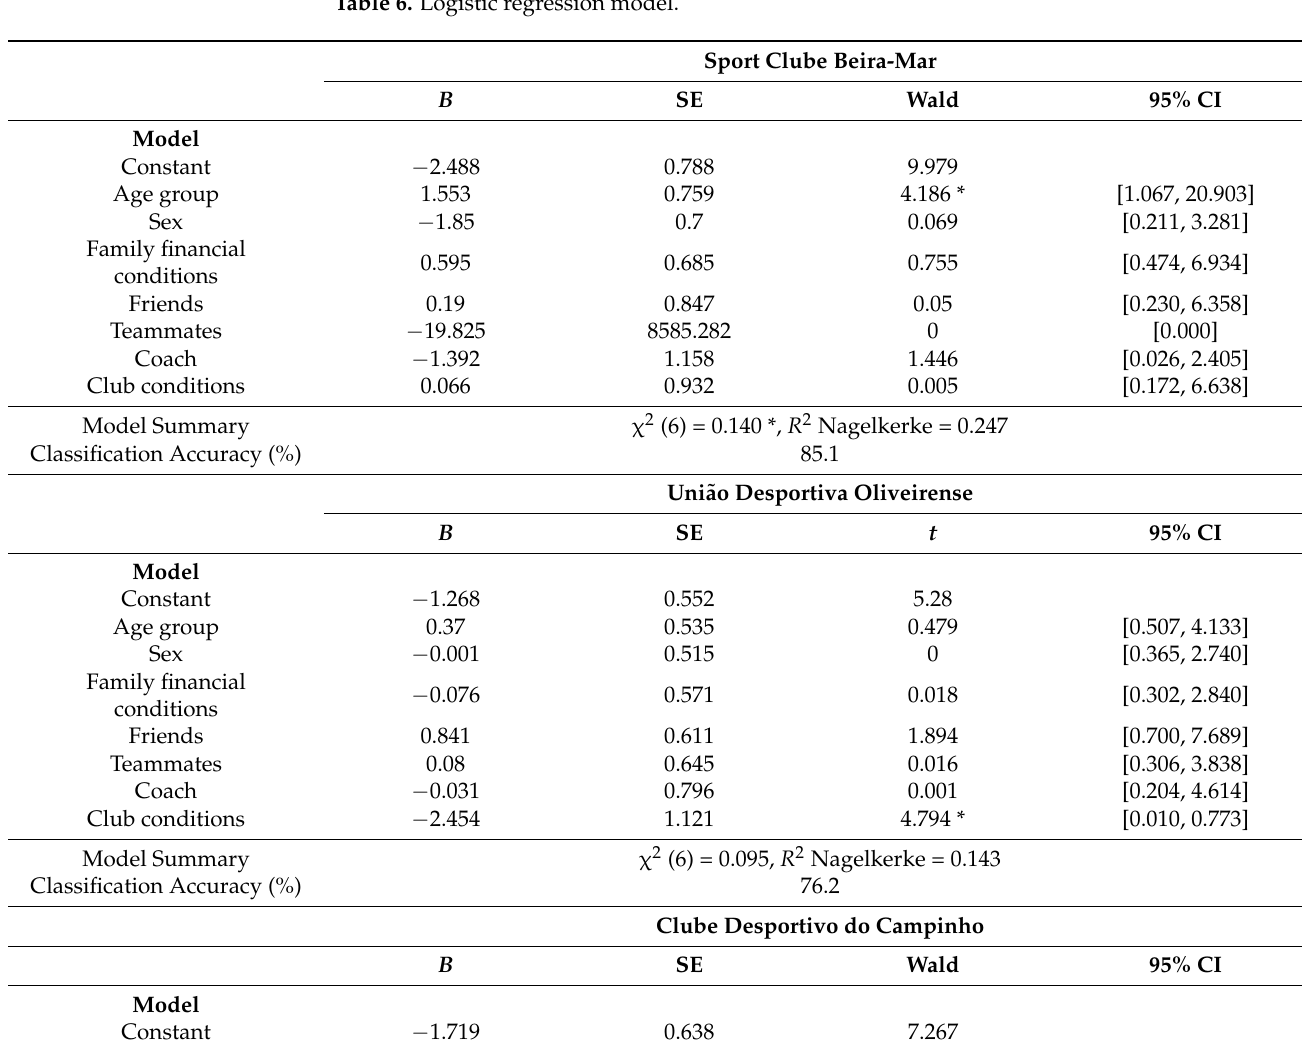
Table 6. Logistic regression